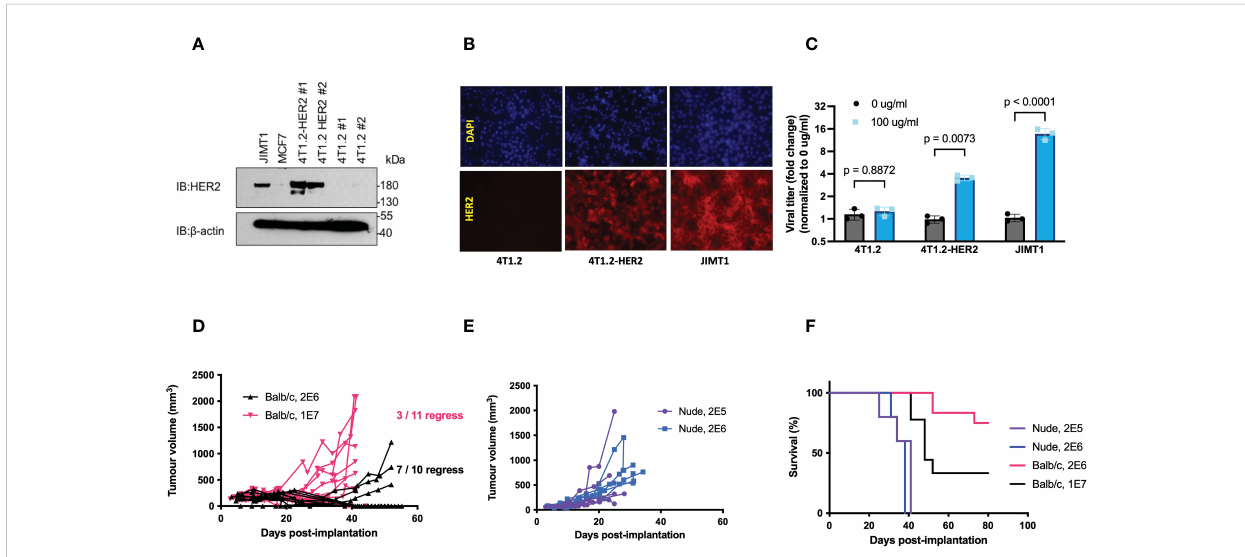
FIGURE 1 Expression of full length hHER2 promotes tumour rejection in immunocompetent BALB/c mice. (A) Western blots of whole cell lysates from JIMT1, MCF7, and two clones of 4T1.2-HER2 and 4T1.2 probed with anti-HER2 antibody and b -actin as loading control. (B) 4T1.2, 4T1.2-HER2, and JIMT1 cells were seeded on glass coverslips, stained with trastuzumab (1:1000), and visualized using a goat anti-human IgG 2 0 antibody conjugated to Alexa Fluor-594 (20x magni fi cation). (C) 4T1.2, 4T1.2-HER2, and JIMT1 cells were treated with PBS or T-DM1 at the indicated concentration for 4 hours, then infected with VSV D 51-Fluc at MOI 0.001; viral output was quanti fi ed 48 hpi (mean ± SEM; n = 3; two-way ANOVA with Fisher ’ s LSD test) (D, E) 4T1.2-HER2 cells were implanted in (D) athymic nude mice or (E) wildtype BALB/c mice at the indicated cell numbers, subcutaneously in the right fl ank. Tumour volume was monitored by measurements using electronic calipers, and (F) overall survival was